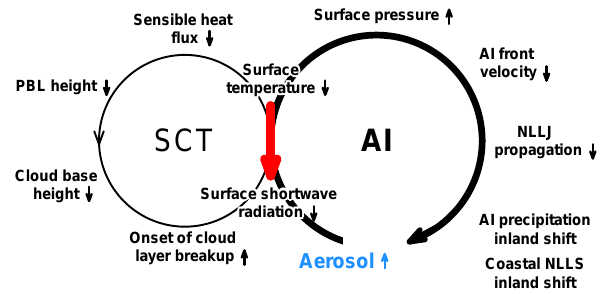
Figure 18. Scheme of the aerosol-related atmospheric feedbacks summarizing the findings of the process study simulations on 2– 3 July 2016. The main loop is labeled AI (Atlantic inflow) and the additional loop SCT (stratus-to-cumulus transition). The small ar- rows in the upward and downward direction denote whether a quan- tity reacts with a decrease (downward) or increase (upward) to the increase in aerosol mass and number (blue) as the initial perturba- tion. The red arrow shows the linkage between AI and SCT via the decrease in shortwave radiation and surface temperature and a po- tential pathway for a negative feedback of SCT on